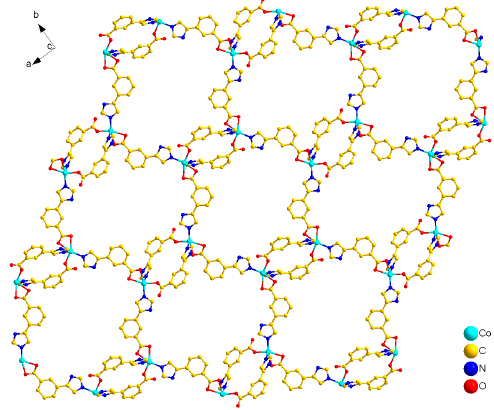
Figure 6. The 2D network structure of 2 .